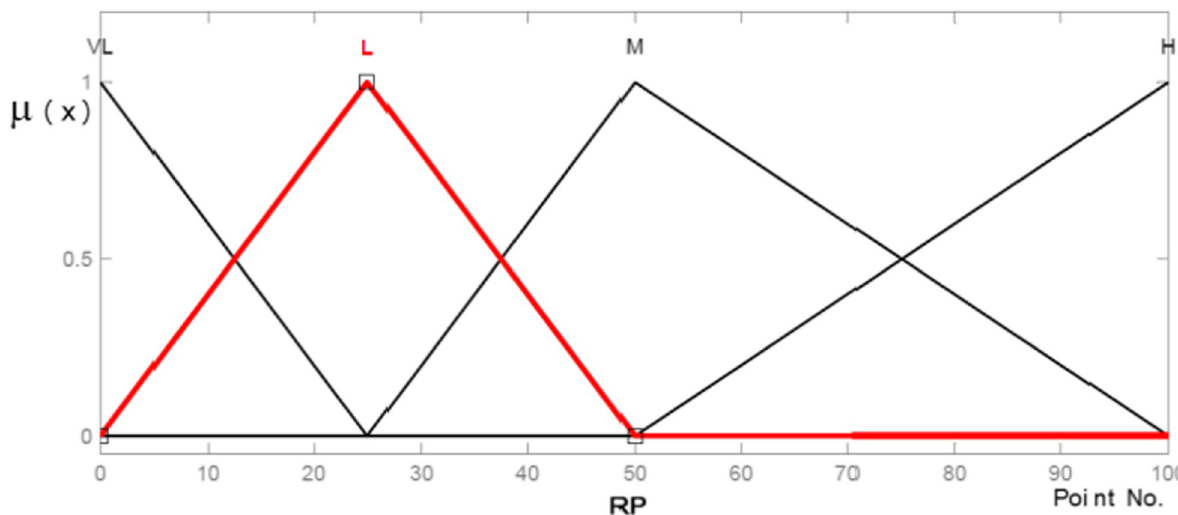
Fig. 4 Membership function for gas pipeline resistance expressed in points